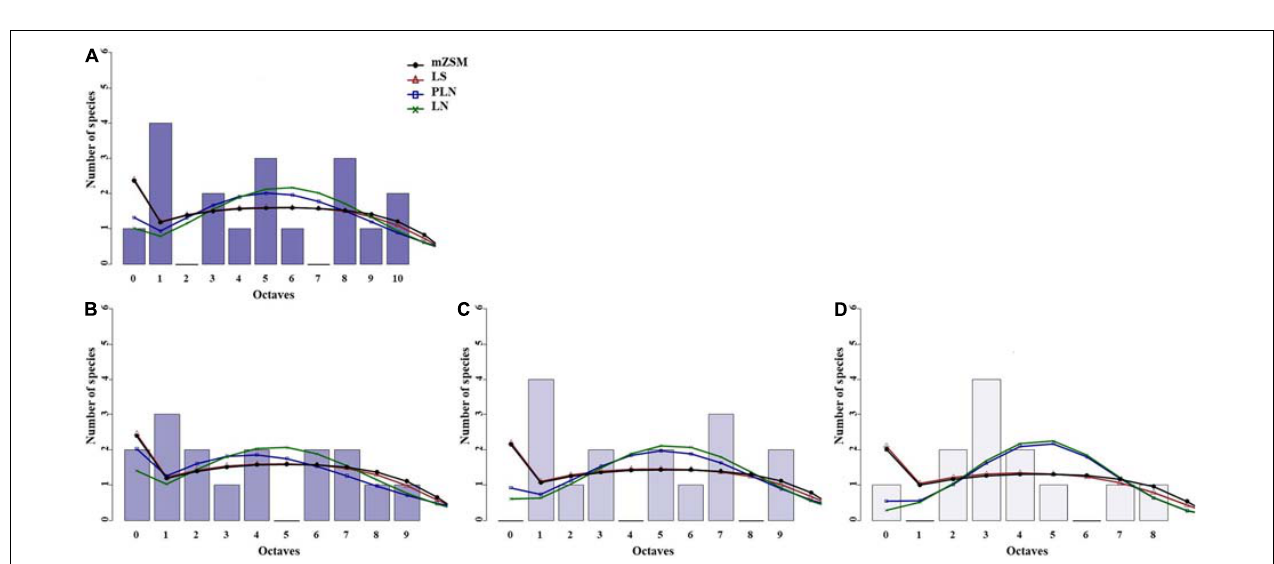
FIGURE 2 | Species abundance distribution (SADs) of carabid beetles in a Chinese typical steppe. SADs were modeled using the lognormal (LN), the Poisson-lognormal (PLN; zero-truncated version), the Fisher log-series (LS), and the metacommunity Zero-Sum Multinomial (mZSM) distributions. Analyses were done for the whole steppe (A) and three different sectors separately [ (B) : ts1 sector, (C) : ts2 sector, (D) : ts3 sector]. Distributions were fitted to the raw abundance data (i.e., not binned). The data were binned for graphical comparison with gambin models, which require